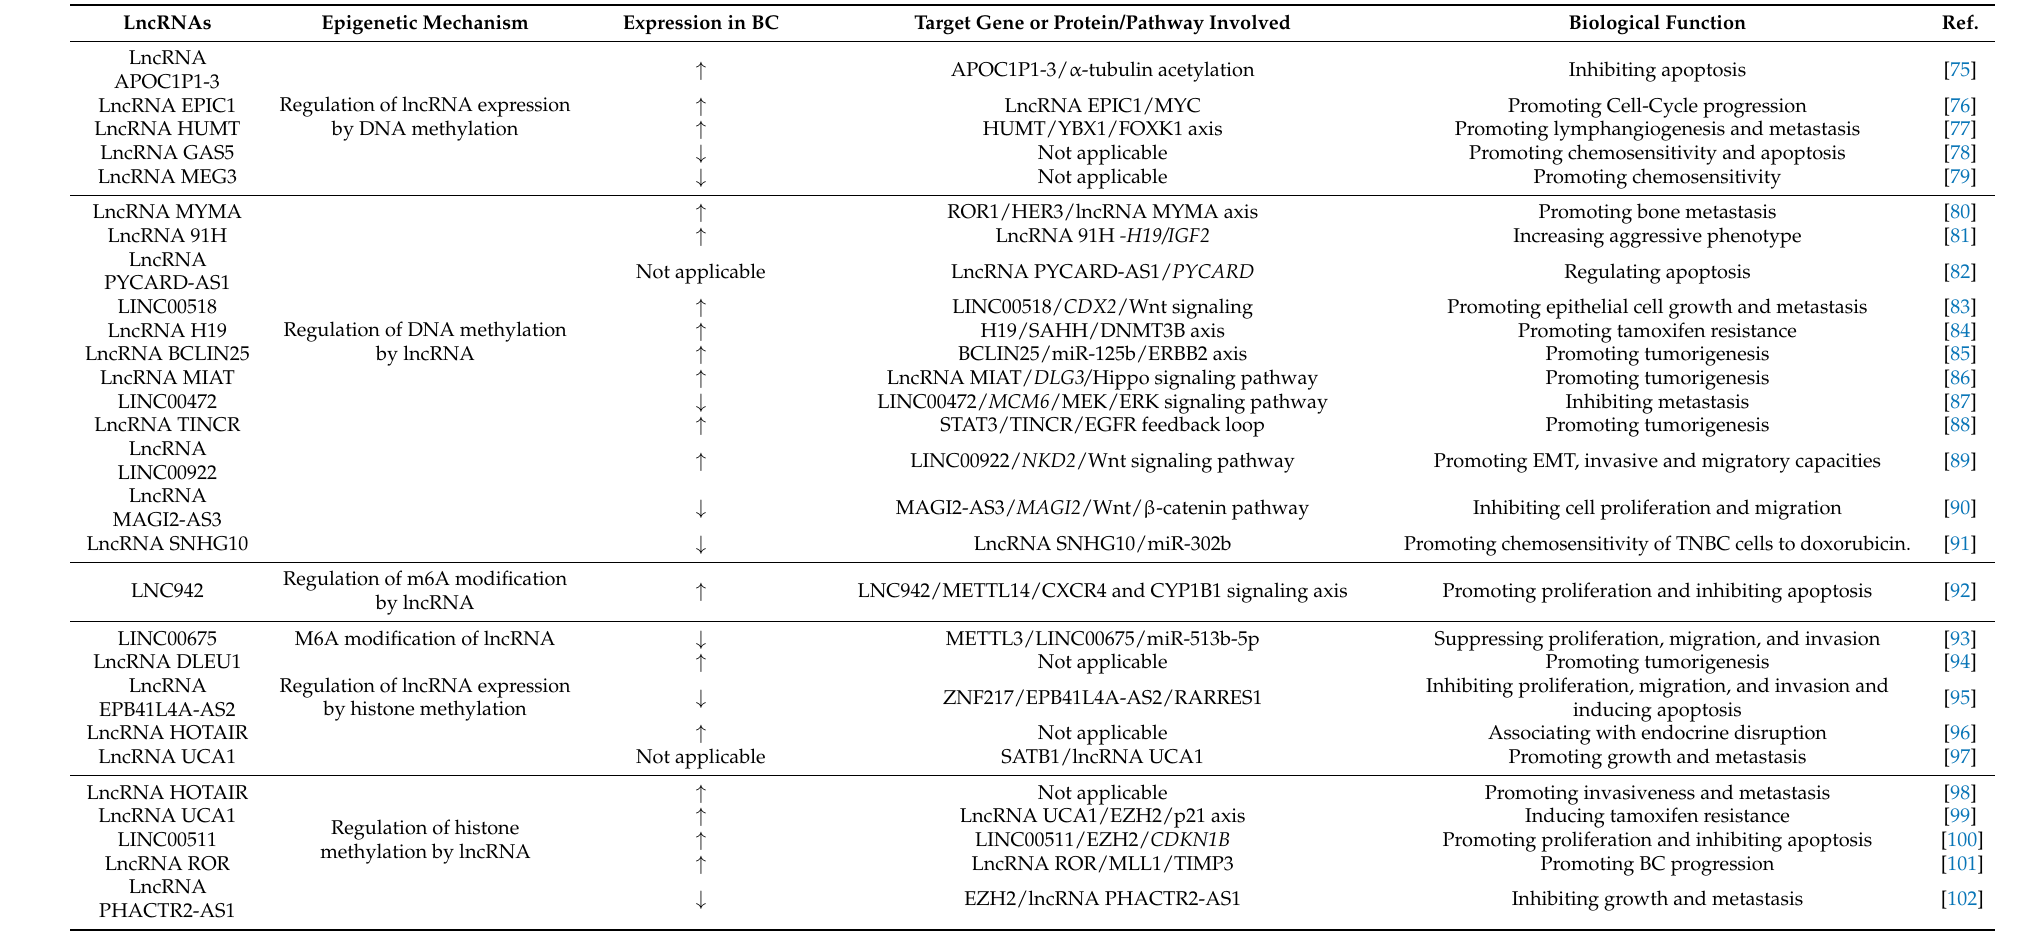
Table 2. Crosstalk between different methylation types and lncRNAs in